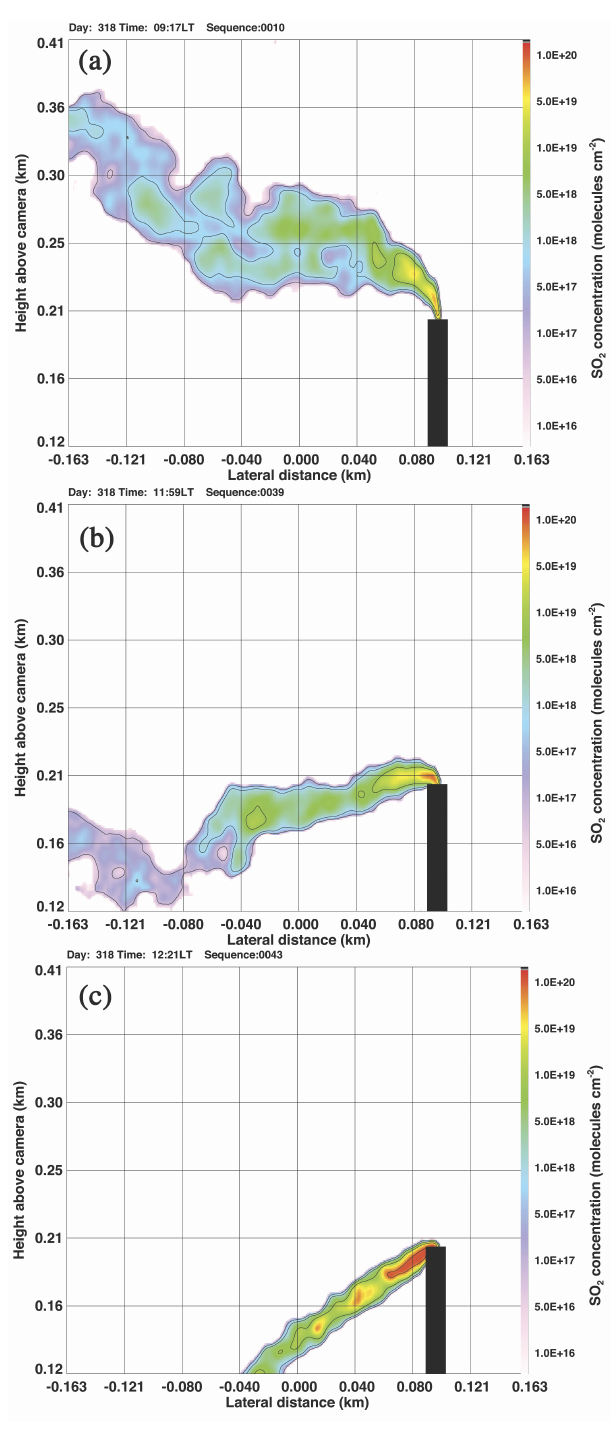
Figure 14. Cyclops measurements of the SO 2 plume from the industrial stack at the Port Pirie lead smelter, showing different behaviours of the plume. (a) Lofted plume, (b) fumigation and (c)